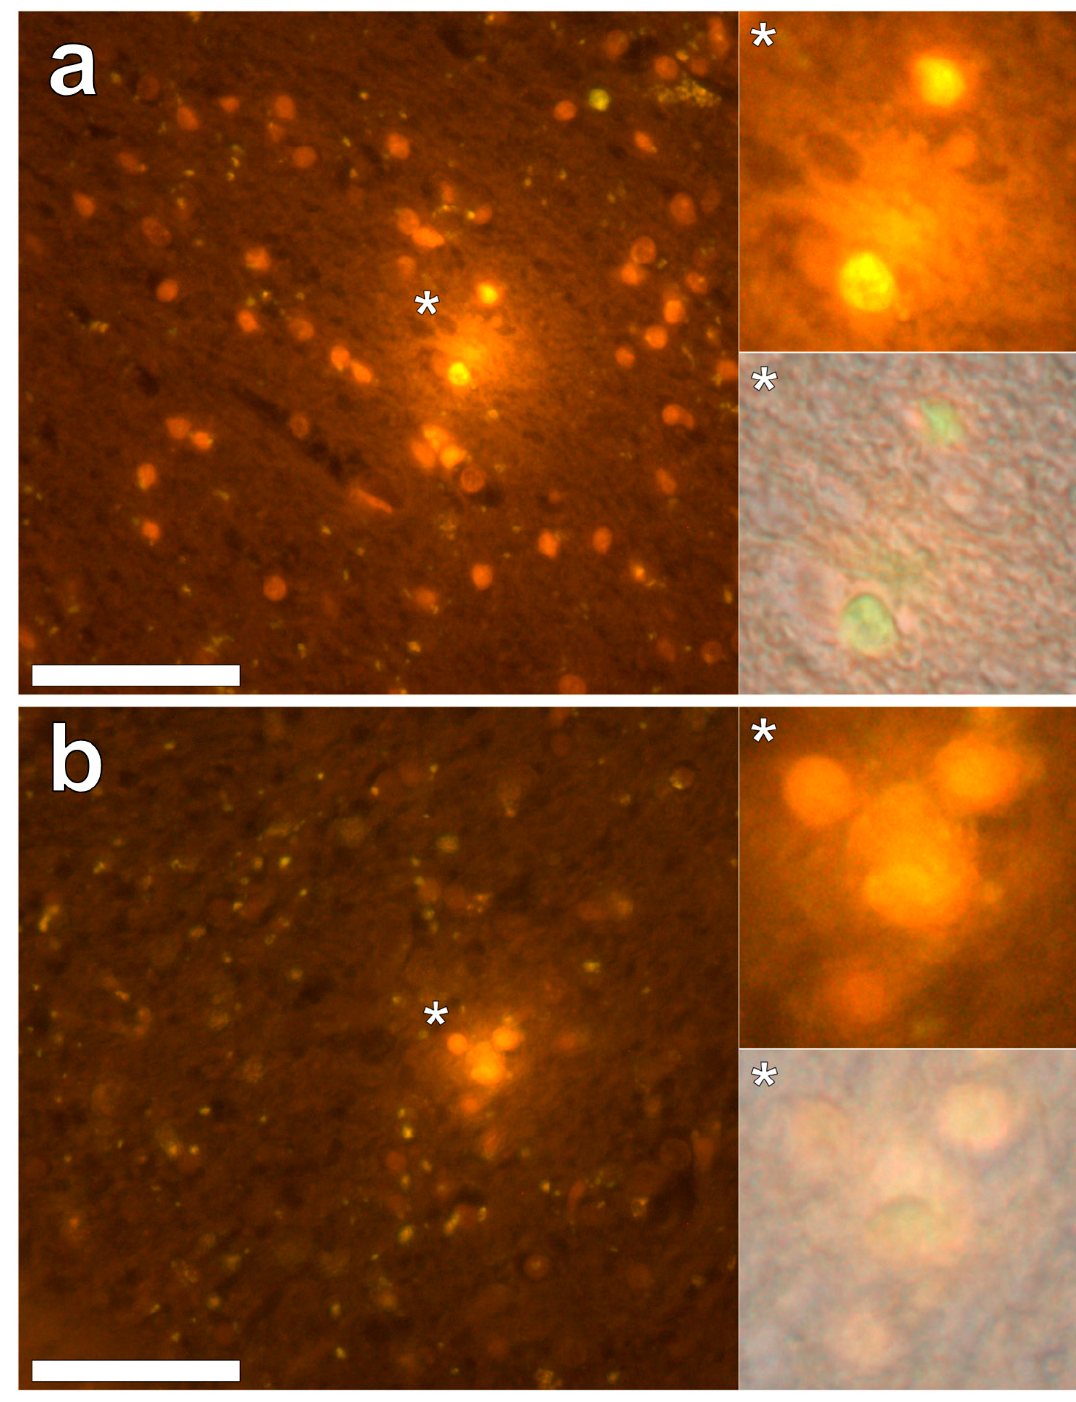
Figure 4. Intracellular aluminium in glial-like cells and within surrounding cellular debris in the parahippocampal gyrus ( a ) and in glial cells exhibiting astrocyte-like processes in the hippocampus ( b ). Magnified inserts are depicted (asterisks) with the bright field channel overlaid. Magnification × 400, scale bars: 50 µm.